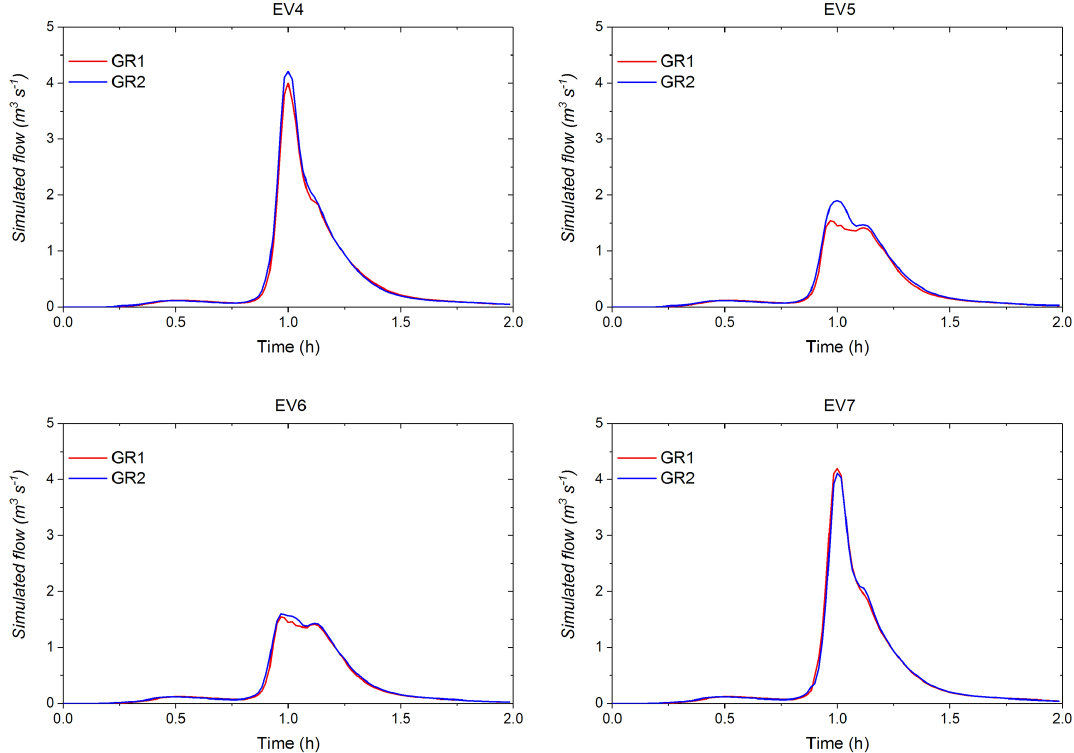
Figure 18. Simulated flow (cubic metres per second) of GR1 and GR2 scenarios under the four syntactic rainfall events.